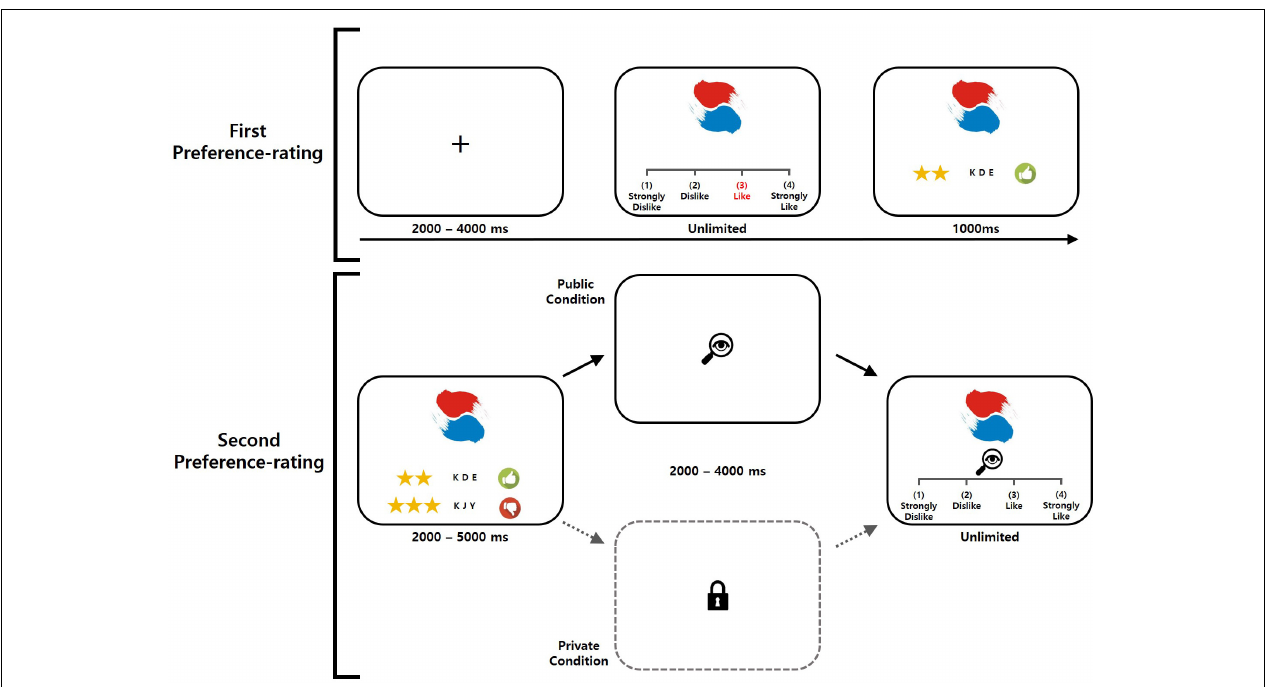
FIGURE 2 | Schematic diagram of the preference rating task. Prior to the task, participants were informed that their final decisions in the public condition trials would be viewed by both their superior and their inferior immediately after the end of the preference rating task and before the modified dictator game. In contrast, participants were informed that in the private condition trials, their preference ratings would remain completely anonymous. Each trial of the task consisted of five distinct